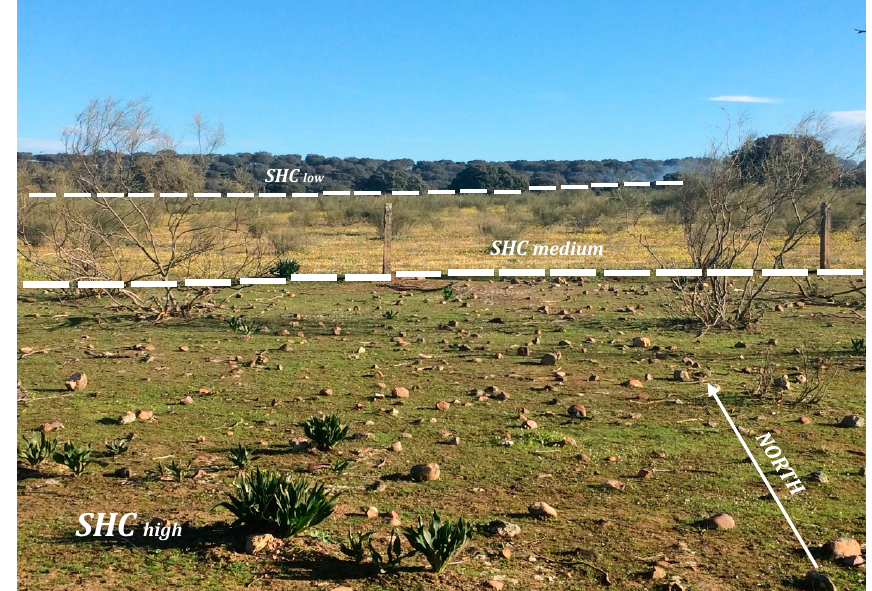
Figure 2. A picture taken in the study area showing the general characteristics of the environments classified as SHC high , SHC medium , and SHC low .